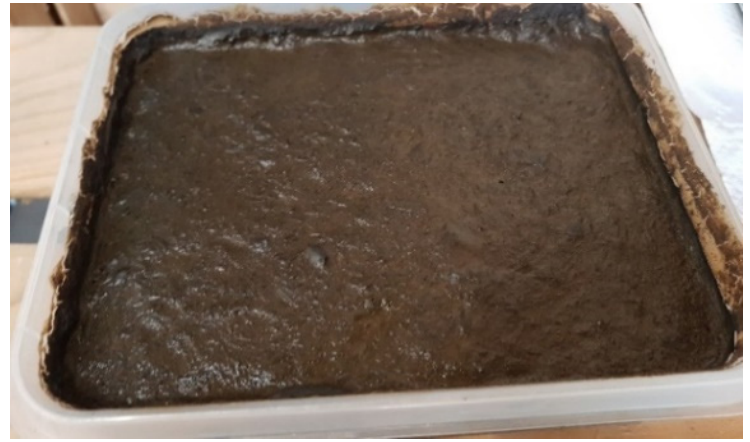
Figure A1. Control slurry at day 42, dried surface crust formation visible.